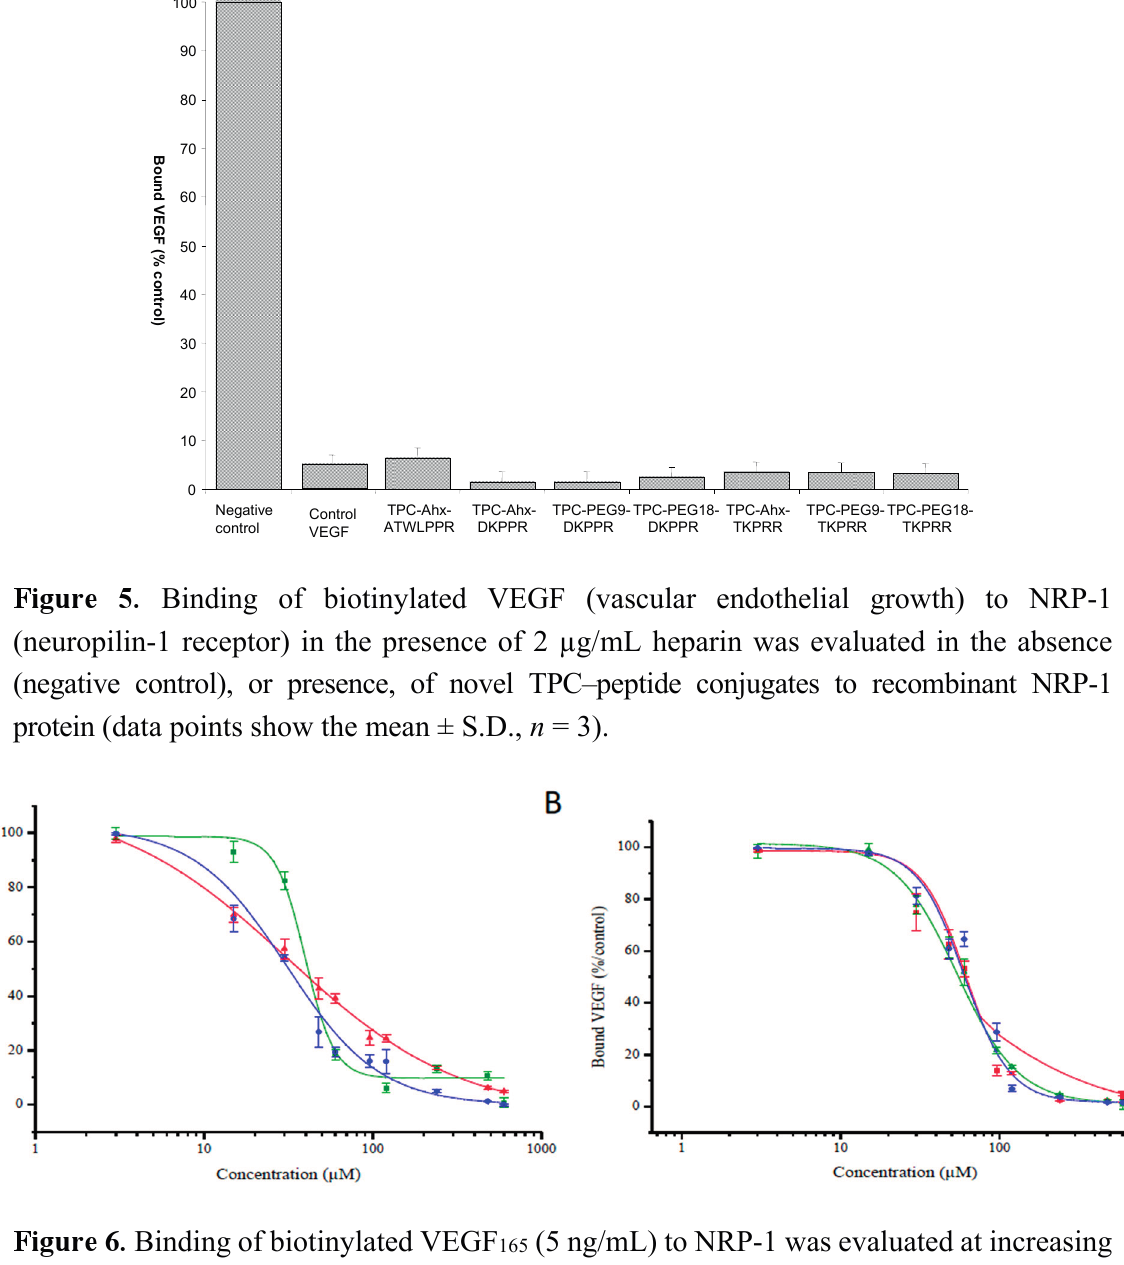
Figure 6. Binding of biotinylated VEGF 165 (5 ng/mL) to NRP-1 was evaluated at increasing concentration of TPC–peptide conjugates (3 to 960 µM) (data points show the mean ± S.D., n = 3). ( A ) Binding of different DKPPR–TPC conjugates to NRP-1 receptor; ( B ) Binding of different TKPRR–TPC conjugates with NRP-1 receptor. The different spacers were illustrated by colors: red for Ahx, green for PEG9 and blue for